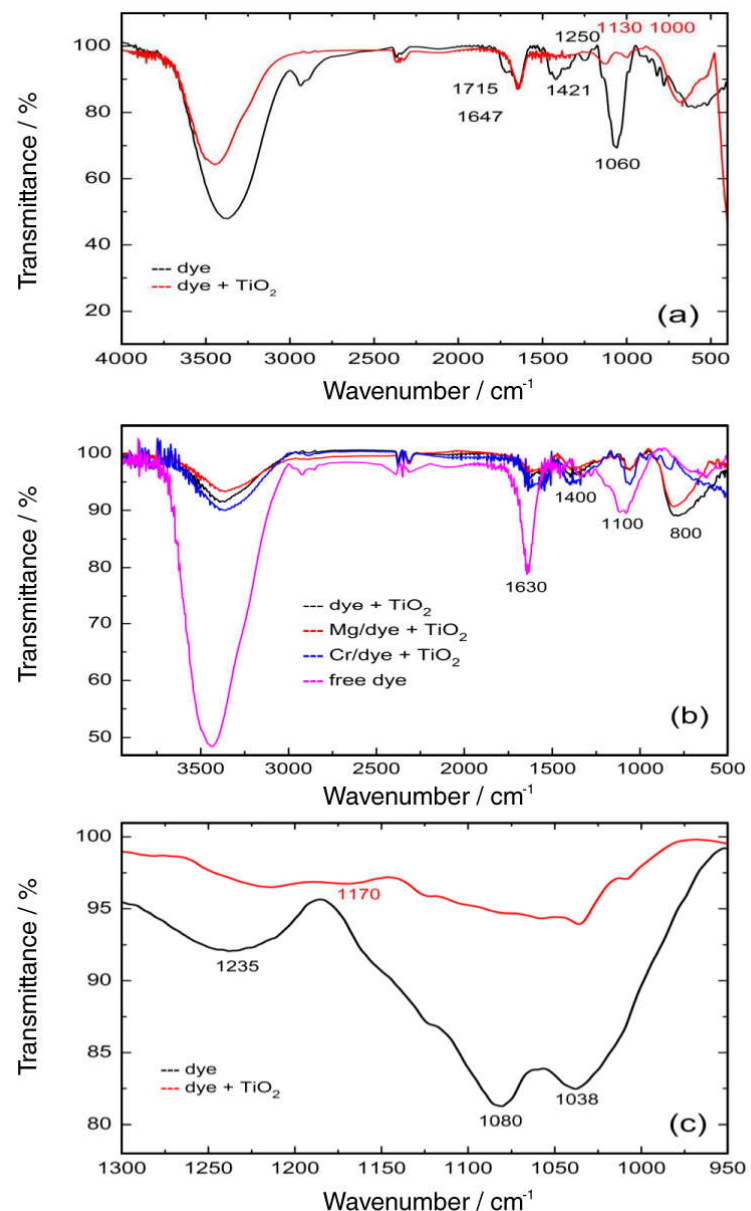
Figure 3. FTIR spectra for the purified solution containing the dye under evaluation and the pigments after incubation for 24 h onto TiO 2 electrodes. 1% KBr pellets. ( a ) Delphinidin-3-glucoside extracted from blueberries (black line) and the adsorbed pigment (red line). ( b ) Delphinidin-3-glucoside extracted from Eugenia uniflora L. (purple line) and the adsorbed pigment (black line); the metallic complex obtained from Cr and Delphinidin-3-glucoside adsorbed onto TiO 2 (blue line) or the metallic complex obtained with Mg adsorbed onto TiO 2 (red line). ( c ) Fucoxanthin (black line) and the adsorbed pigment (red line).